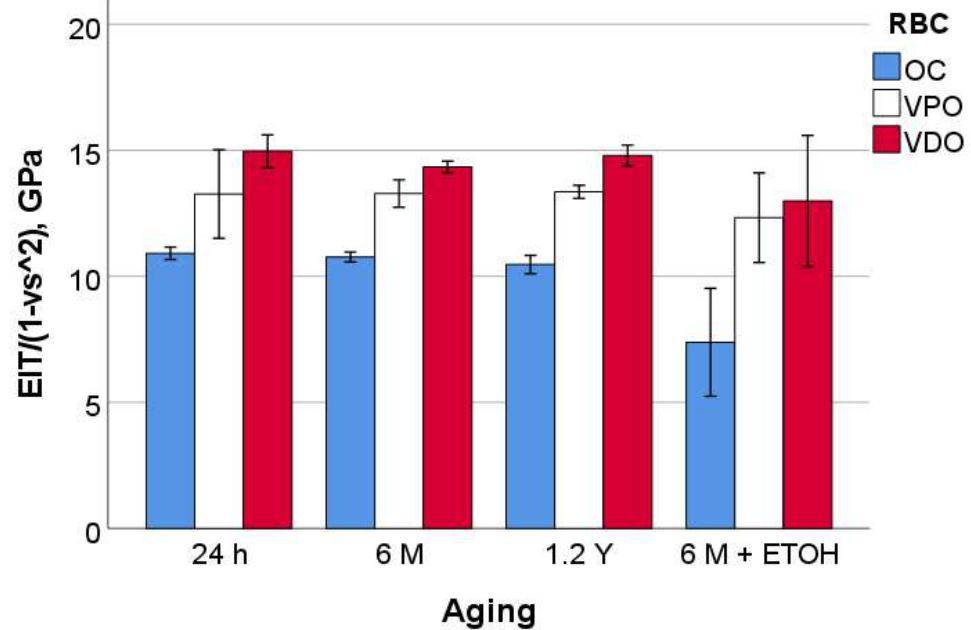
Figure 4. Indentation modulus (E IT ) as a function of RBC and aging method (mean values with 95% confidence interval).